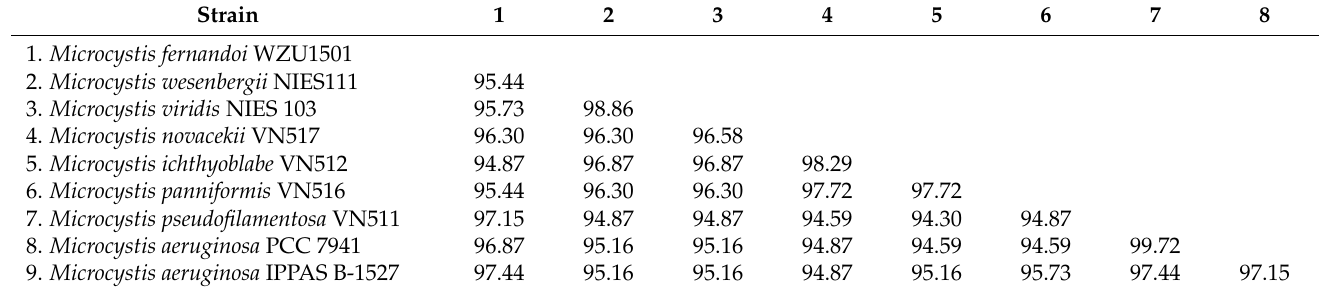
Table 3. Sequence similarity comparison of the ITS between Microcystis fernandoi WZU 1501 and other related taxa. Similarity = [1 − (p-distance)] × 100.